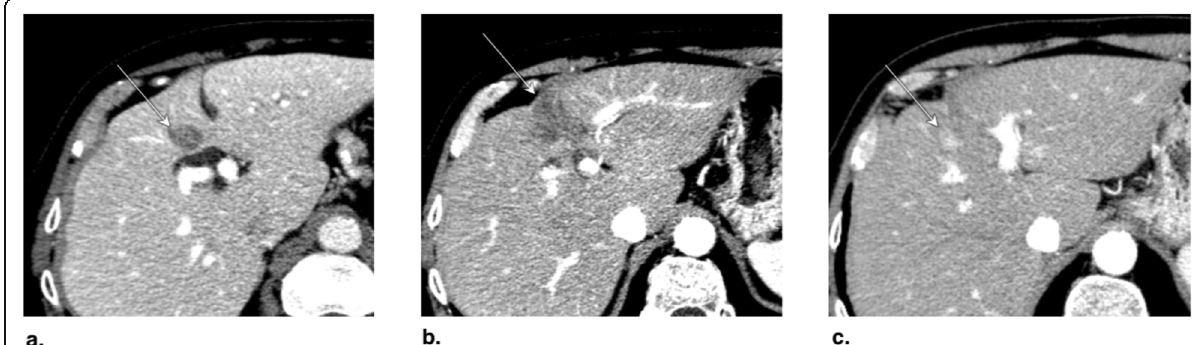
Fig. 10 a Axial CT in portal venous phase obtained pretreatment: image shows washout of a 2.5-cm LR-5 observation. Proximity to gallbladder and biliary bifurcation contraindicates radiofrequency ablation. Axial CT in late arterial phase obtained 1 month post percutaneous ethanol ablation: images show ( b ) hypoenhancement of the treatment area (arrow), with ( c ) nodular arterial phase hyperenhancement at the upper margin of the treated lesion indicating viable tumor (arrow). The treated observation is categorized LR-TR